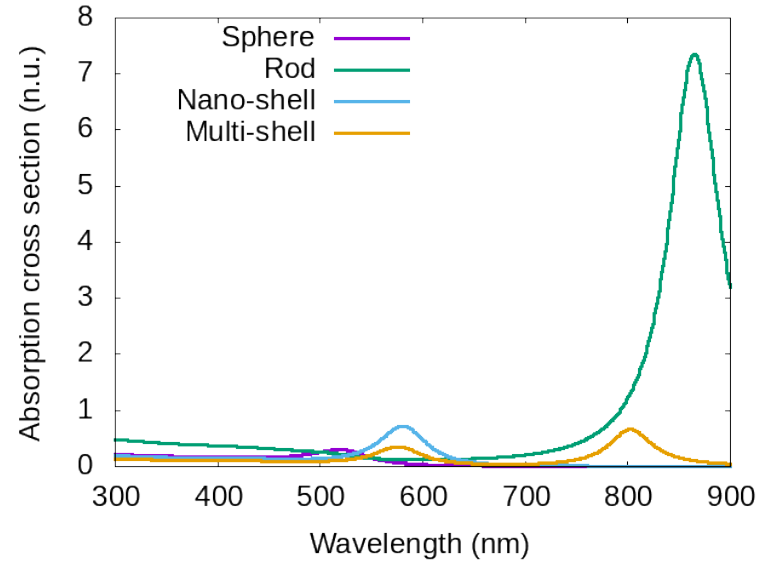
Figure 3. Curves represent the absorption cross section of four MNPs with the same total volume and immersed in water: purple line for a gold nano-sphere with radius 10 nm, green line for a gold nano-rod with long axis 16 nm and short axis ∼ 7.9 nm, blue line for a nano-shell made of a silica core (radius 7 nm) and a gold shell of 3 nm, Yellow line for a multi-shell structure obtained starting from a dielectric core and alternating gold/dielectric shell with total radius 10